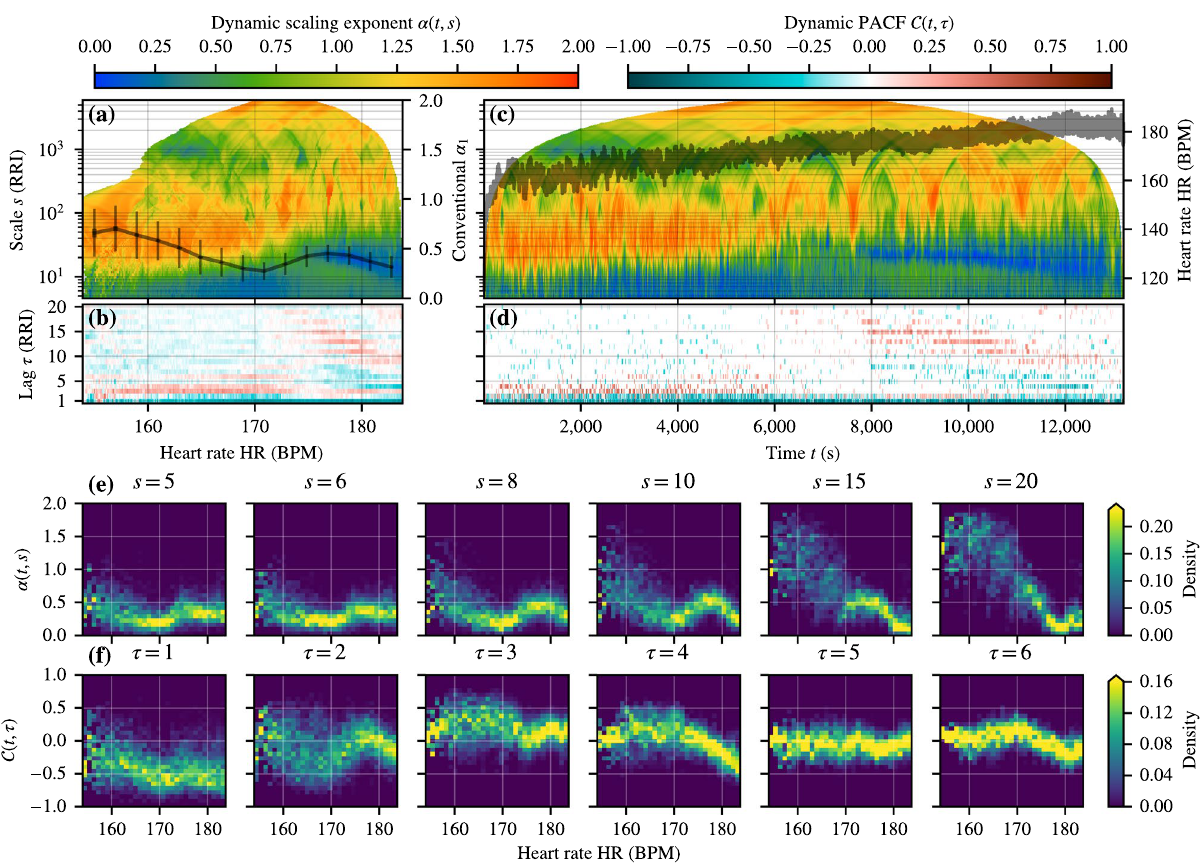
Figure 1. Beat-to-beat (RR) interval correlations for the Marathon race of subject M1. Note that the upper-left and upper-right color bars refer to ( a , c ) and ( b , d ), respectively. ( a ) Color-coded dynamic (DDFA-1) scaling exponent α( t , s ) on different scales s (y-axis) as a function of binned HR (x-axis). Here α( t , s ) is averaged over those dynamic segments, whose average HR falls within 0.1 BPM wide bins. The values for empty bins are linearly interpolated if the gap does not exceed 0.5 BPM. The black solid line shows the mean together with the standard deviation (thin lines) and the the standard error of the mean (thick lines, barely visible) of the conventional short-scale (4–16 RRIs) scaling exponent α 1 . The exponent is computed in moving windows of 50 RRIs in HR bins of 2 BPM. ( b ) Color-coded partial autocorrelation functions (DPACF-0) C ( t , τ) with different lags τ (y-axis) as a function of the binned HR. ( c ) Similar to ( a ) but as a function of time during the marathon race. The instantaneous heart rate is overlaid on the data. ( d ) Similar to ( b ) but as a function of time. The values that do not pass the non-zero significance test as described in the text are shown in white. ( e ) Probability density histogram for α( t , s ) for different scales s as a function of the HR. ( f ) Probability density histogram of the DPACF-0 for different lags τ as a function of the HR. The histograms in ( e , f ) consist of 31-by-31 bins, and the probability densities are separately normalized for each HR bin, so that they better depict the distributions as a function of the HR instead of measuring the prevalence of different HR regions. Furthermore, the color bar is capped at the 99.5th percentile to avoid outliers dominating the color